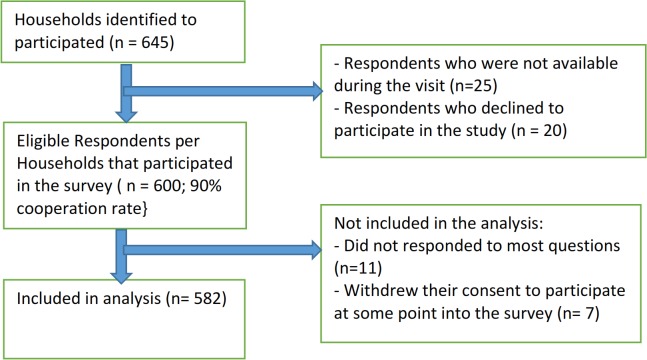
Sample selection framework.